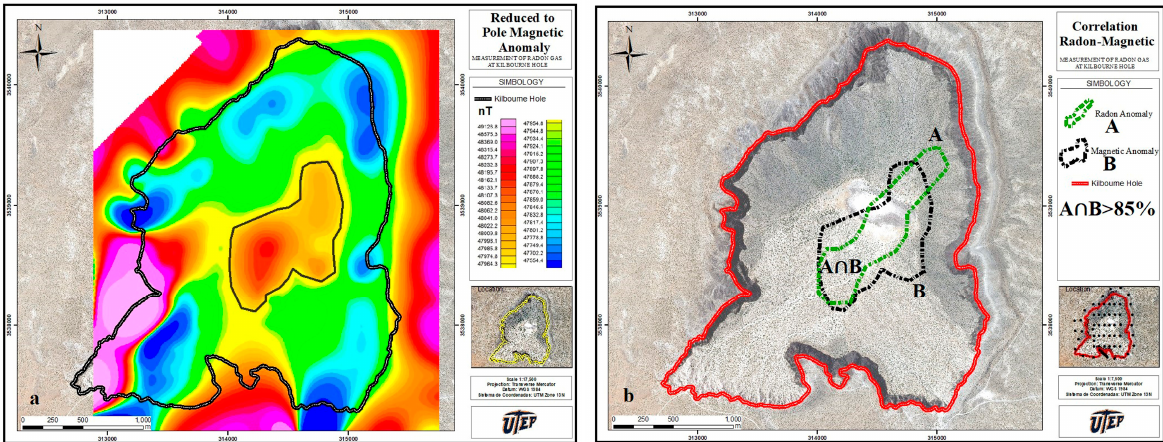
Figure 6. ( a ) RTP magnetic map of Kilbourne Hole, with black line delimiting the magnetic anomaly, from Maksim (2016). ( b ) C Rn and magnetic field anomaly show the overlapping regions (>85%).